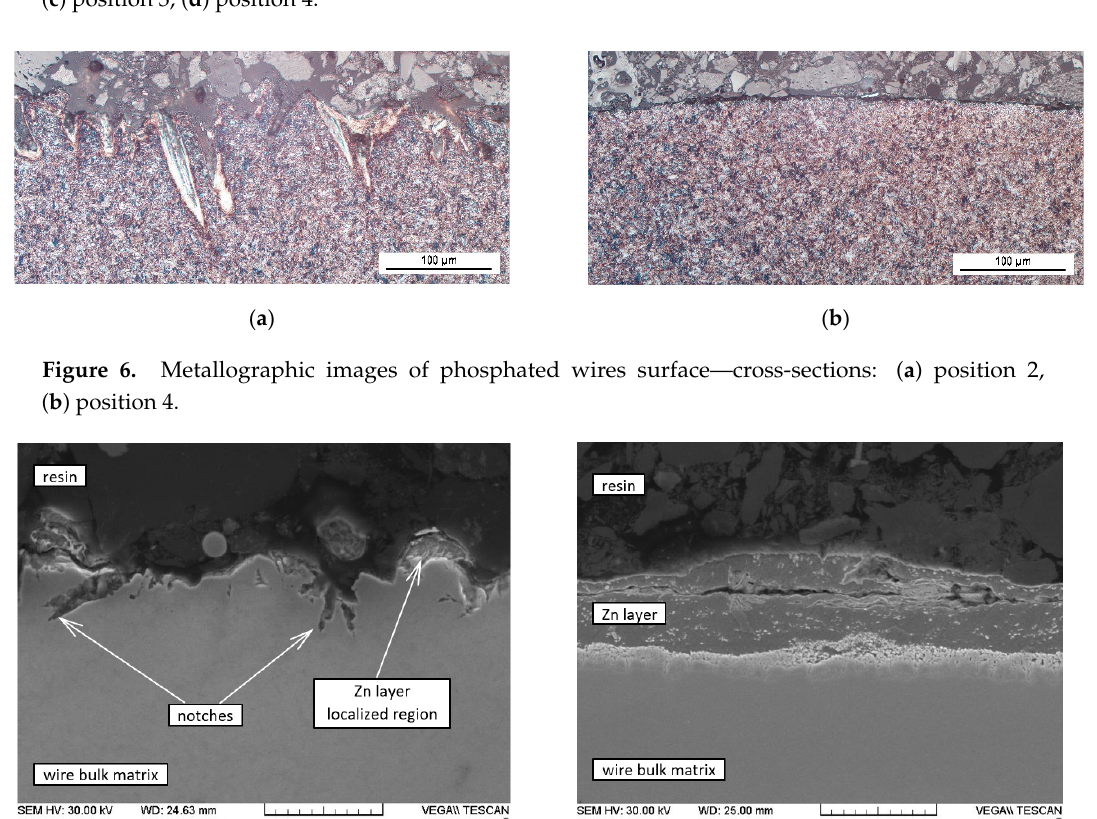
Figure 5. Metallographic images of compacted wire surface—cross-sections: ( a ) position 1, ( b ) position 2, ( c ) position 3, ( d ) position 4.